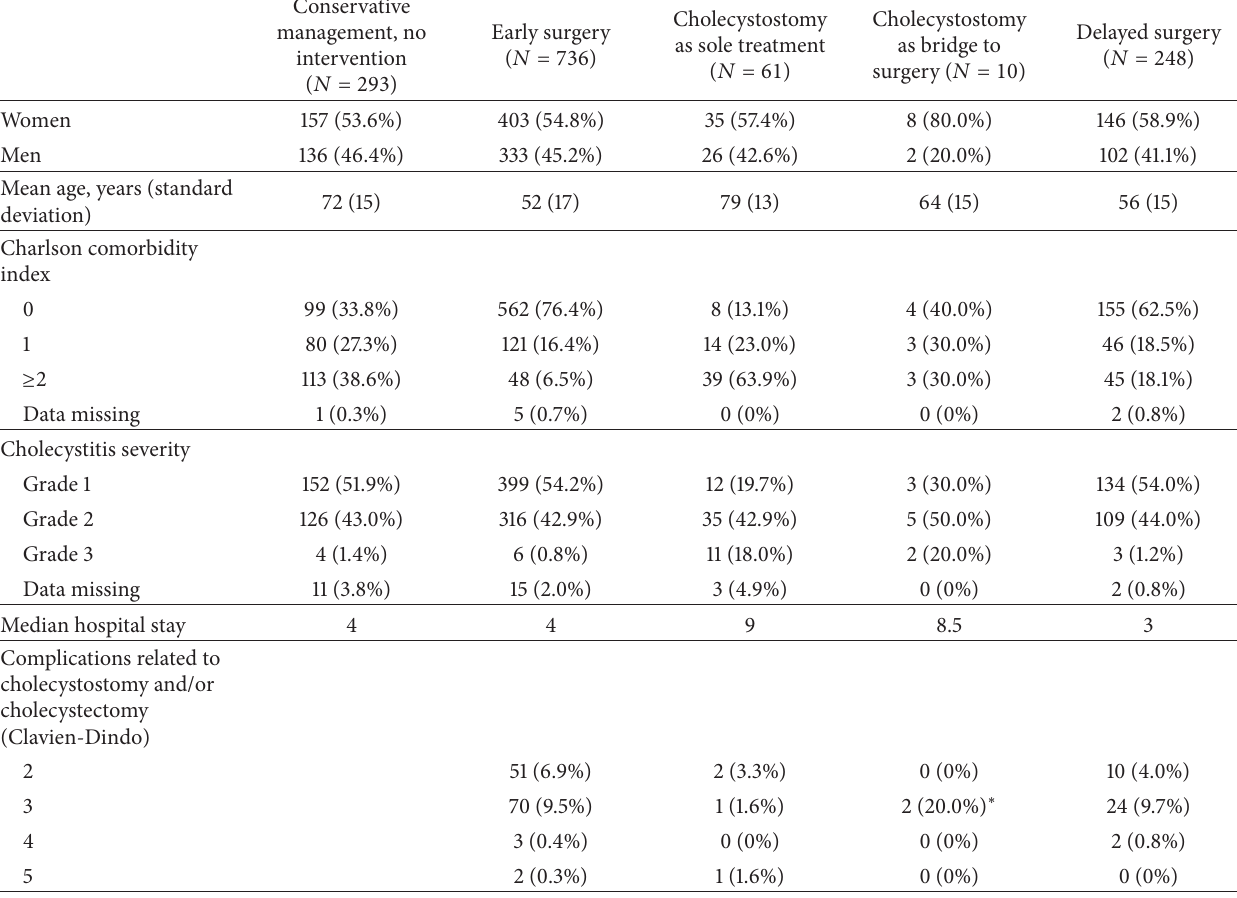
Table 1: Patient characteristics. Information about management was missing or inconsistent for 284